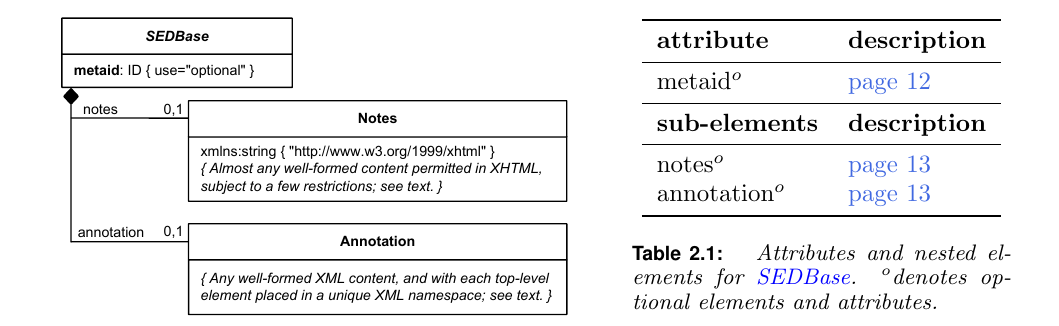
Figure 2.4: The SEDBase class